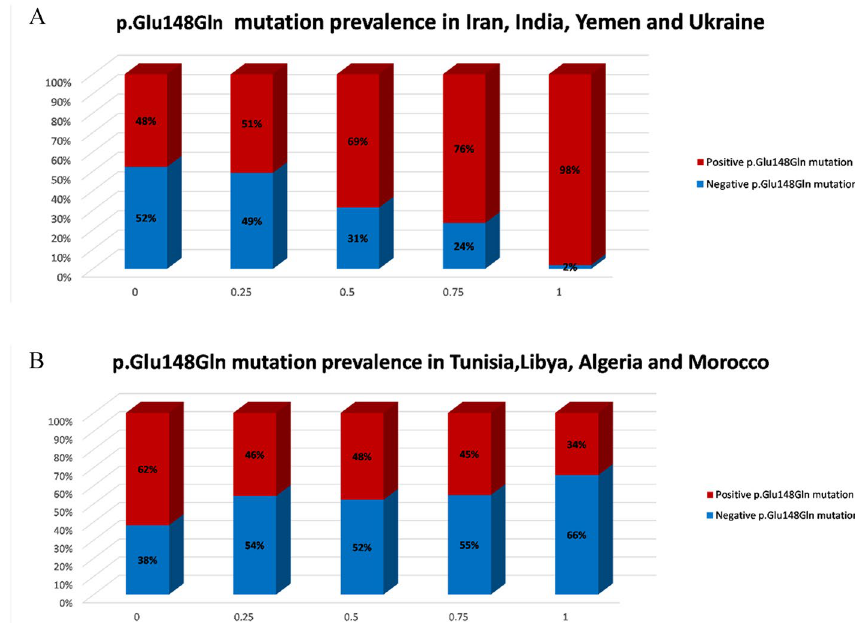
Figure 4. Prevalence of the countries of origin most indicative for the p.Glu148Gln variant: Countries that were found to be the most positively ( A ) and negatively ( B ) associated origins for a patient who carries a positive p.Glu148Gln variant . Red and blue bars represent the patients who carry and do not carry the p.Glu148Gln variant, respectively. The X-axis indicates the amount of grandparents from the four countries (0 being none, 1 being all